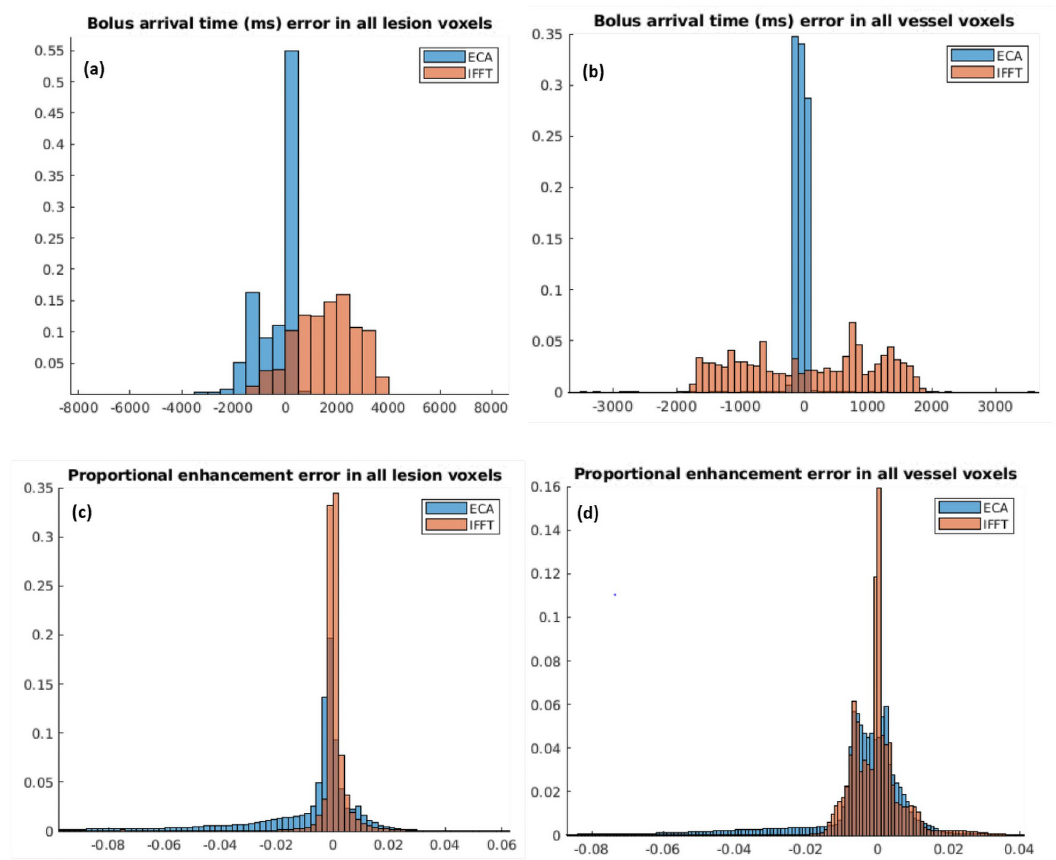
Fig 7. Error distributions are shown for all cases. Distributions for IFFT and ECA are shown in different colors on the same plot. (a) and (b) show errors in the estimation of the bolus arrival time in milliseconds; (c) and (d) show the distribution of the proportional voxel error.